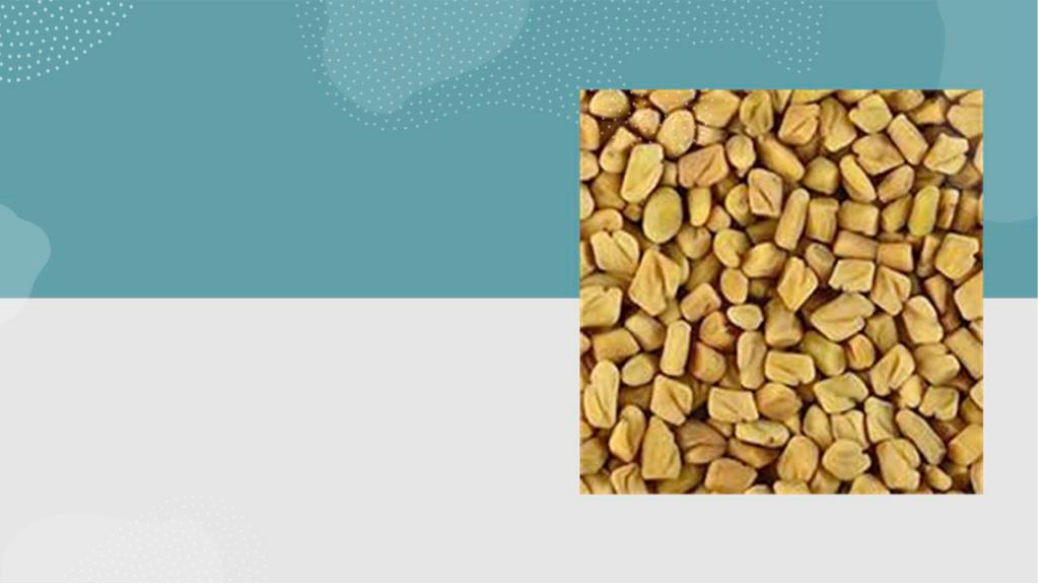
Figure 1. Macroscopic picture of the fenugreek.